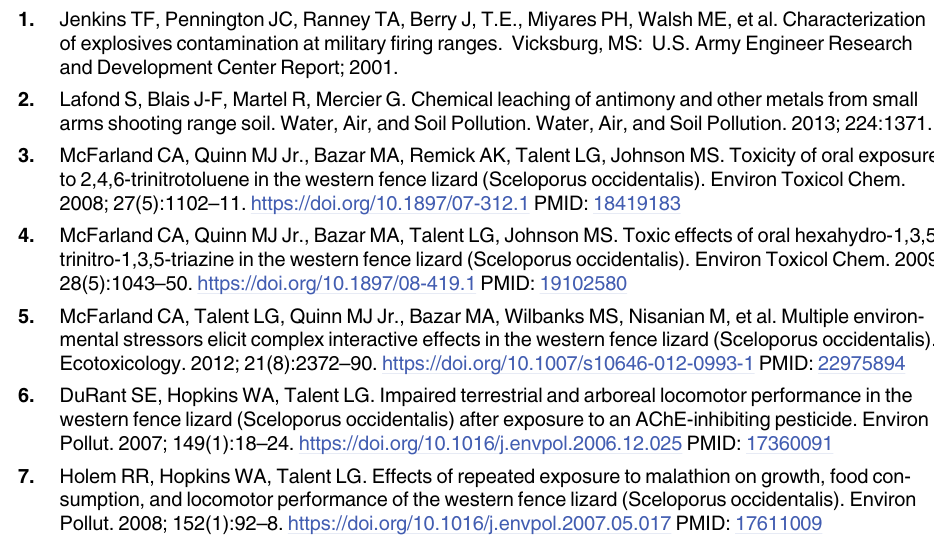
S1 Table. Functional analysis of the predicted gene content (through LEfSe analysis of KEGG orthologous genes and pathways) of the bacterial communities based on the bacte- ria identified by 16S rRNA gene amplicon sequencing between pre-exposed and TNT- exposed